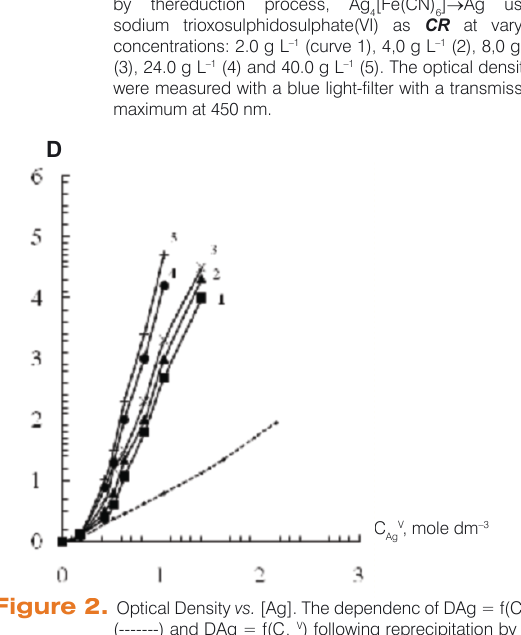
V ) Ag [Fe(CN) ] → Ag using 4 6